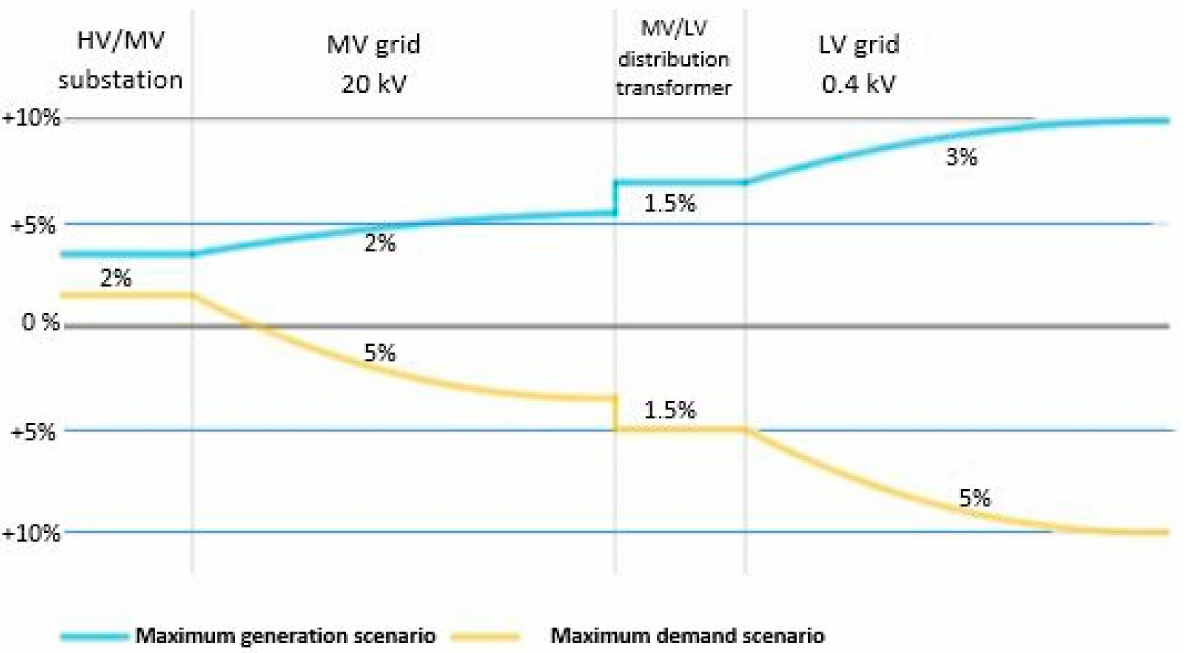
Figure 6. Suggested allocation of voltage ranges